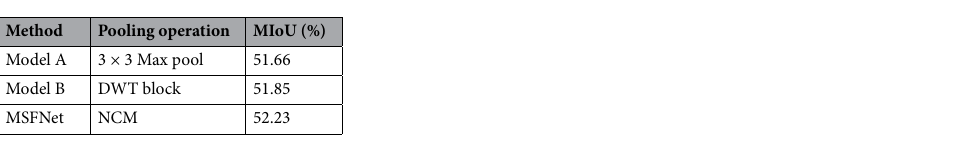
Table 2. Ablation experiment of nonsubsampled contourlet transform